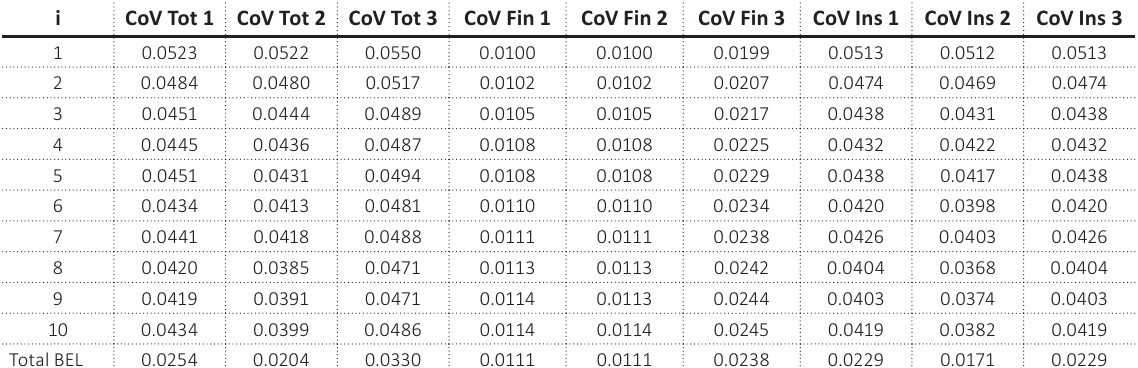
Table 8. Sensitivity analysis on investment risk and insurance